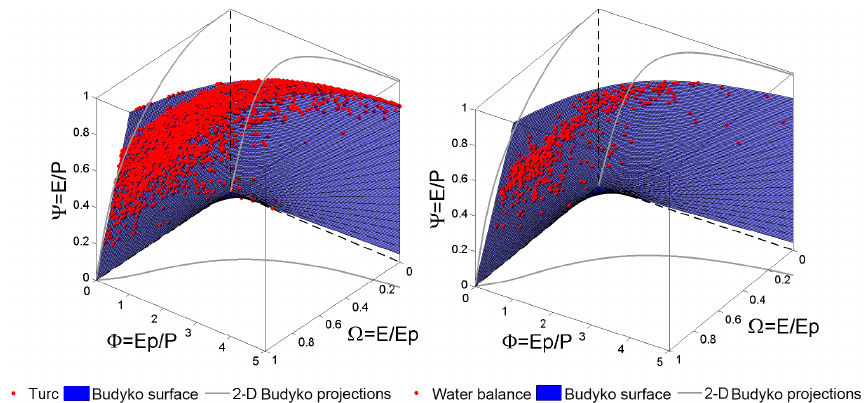
Figure 3. The 3-D state space for the FAO agro-climatic stations (left panel) and catchments in the US and China (right panel). Grey lines represent the 2-D projections of the blue surface estimated with E calculated using Eq.